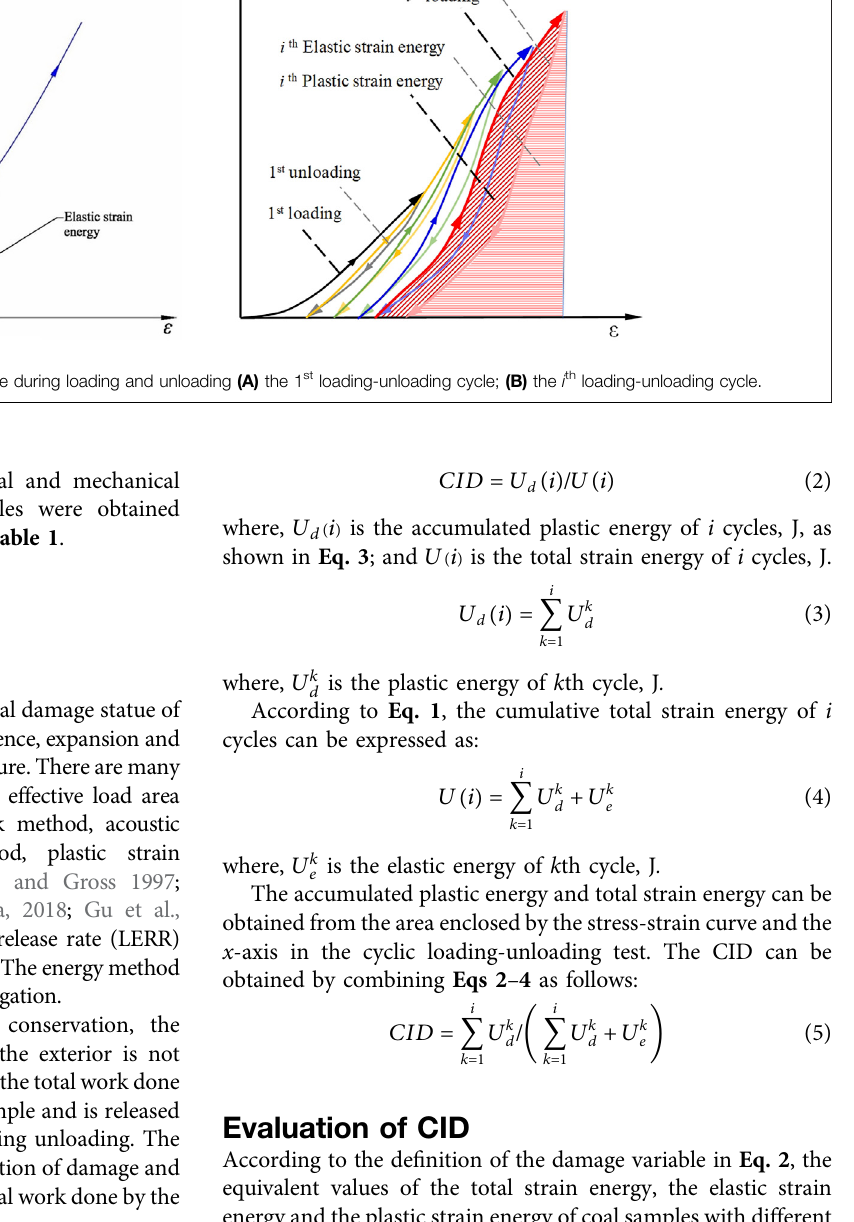
Frontiers in Materials |